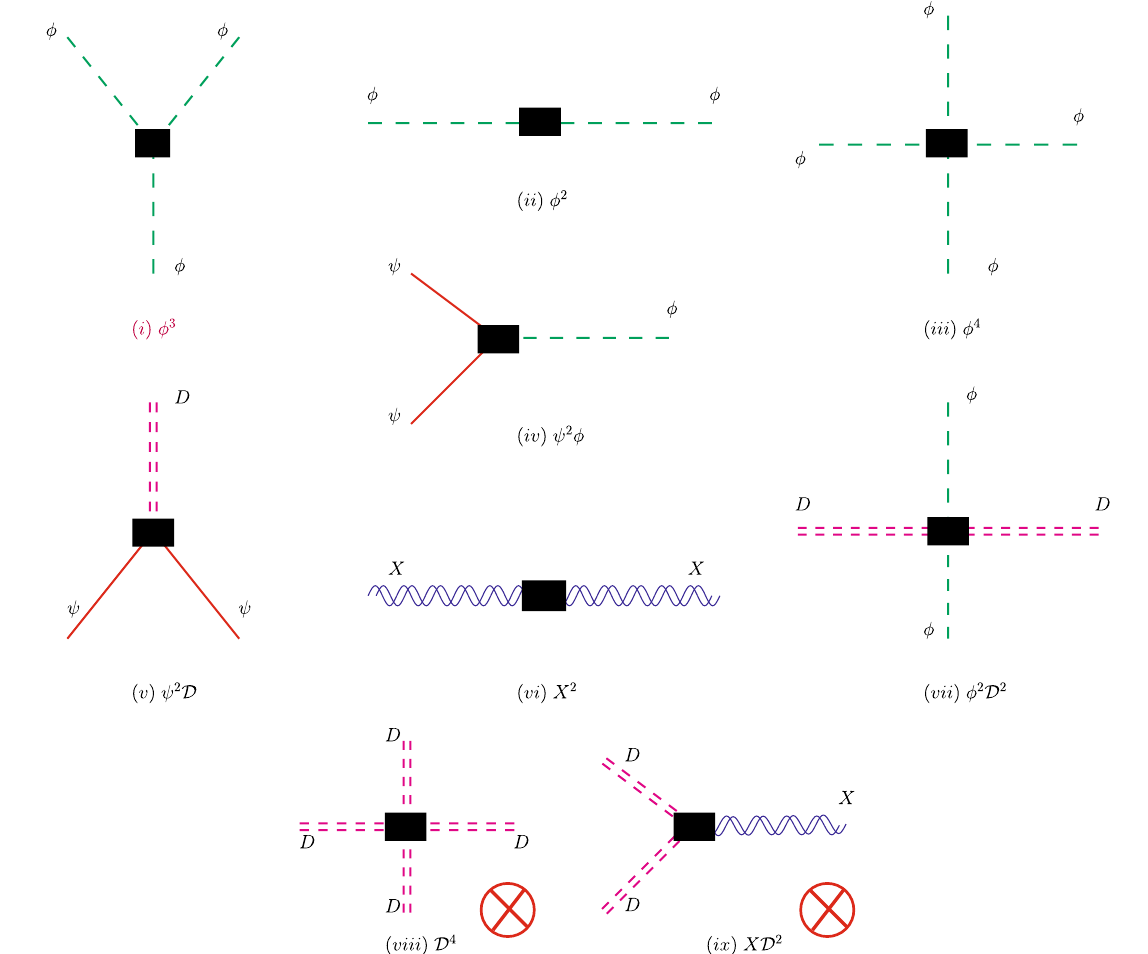
Fig. 1 Diagrammatic representation of operator classes at mass dimension-4 (for 3 + 1 space-time dimensions) or less constituted by combining spin-0 ( φ ), spin-1/2 ( ψ ) and Field Strength Tensor ( X ) of spin-1 fields and the covariant derivative ( D ). Of these, (i) does not